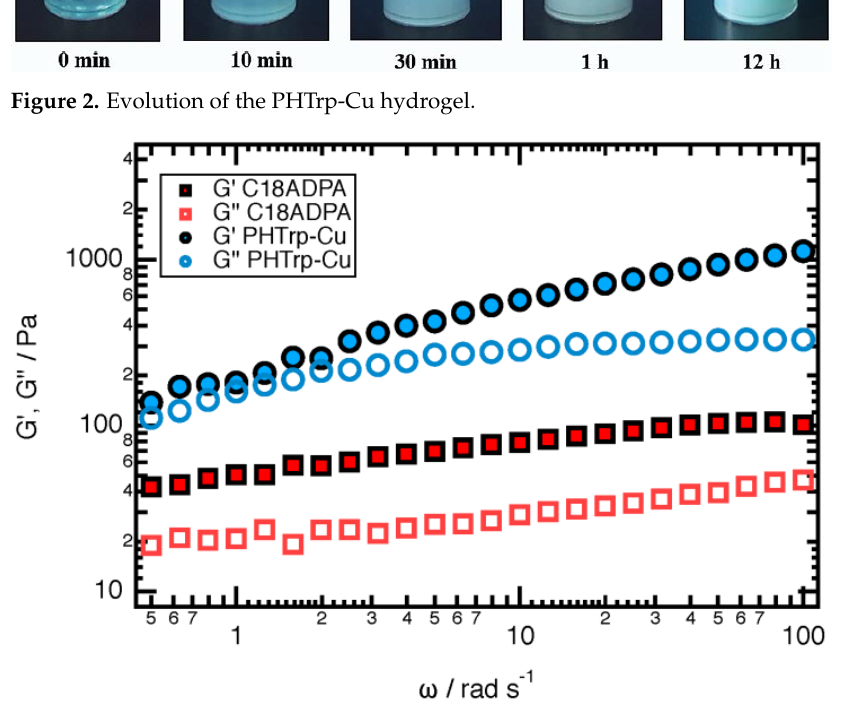
Figure 3. Frequency sweep dynamic rheological data for the C18ADPA hydrogel and the PHTrp-Cu hydrogel.